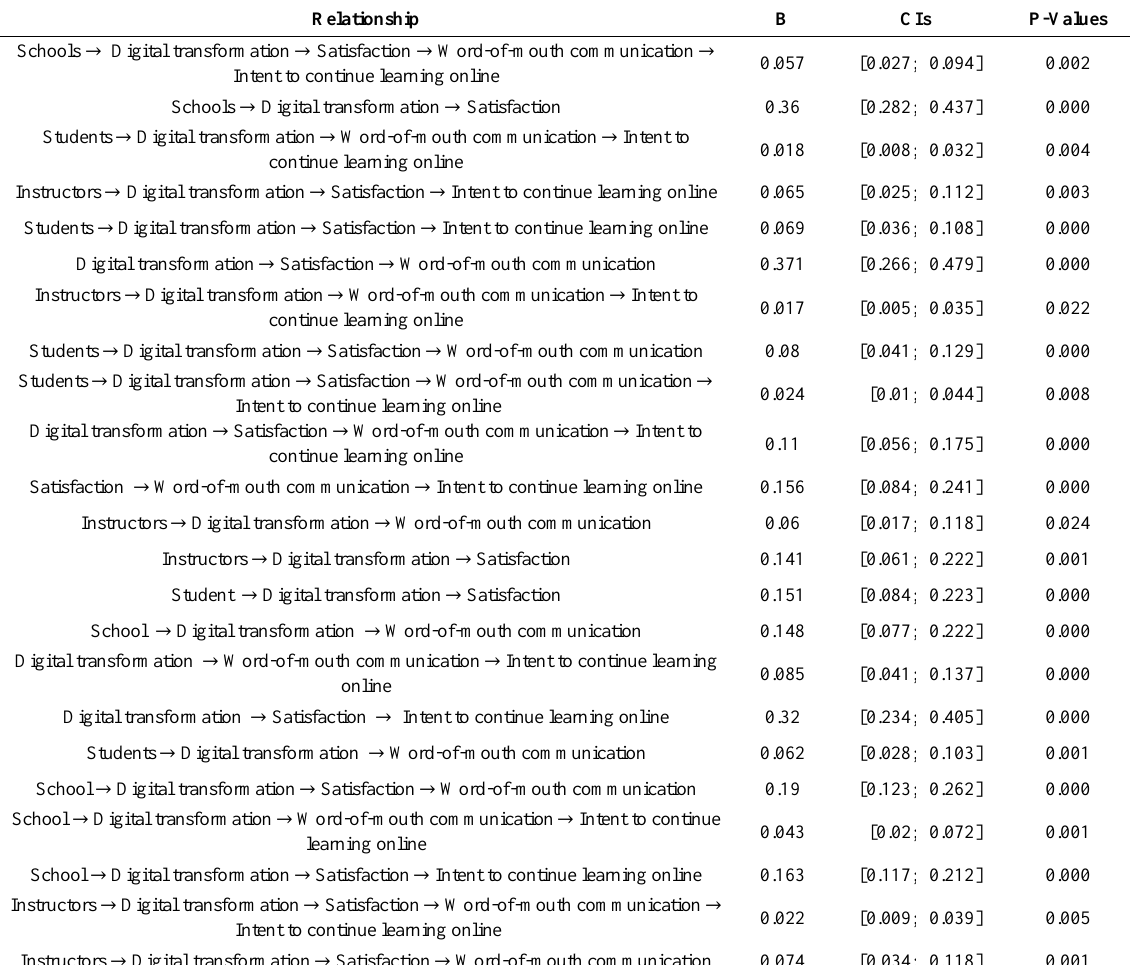
Table 5. Hypothesis test